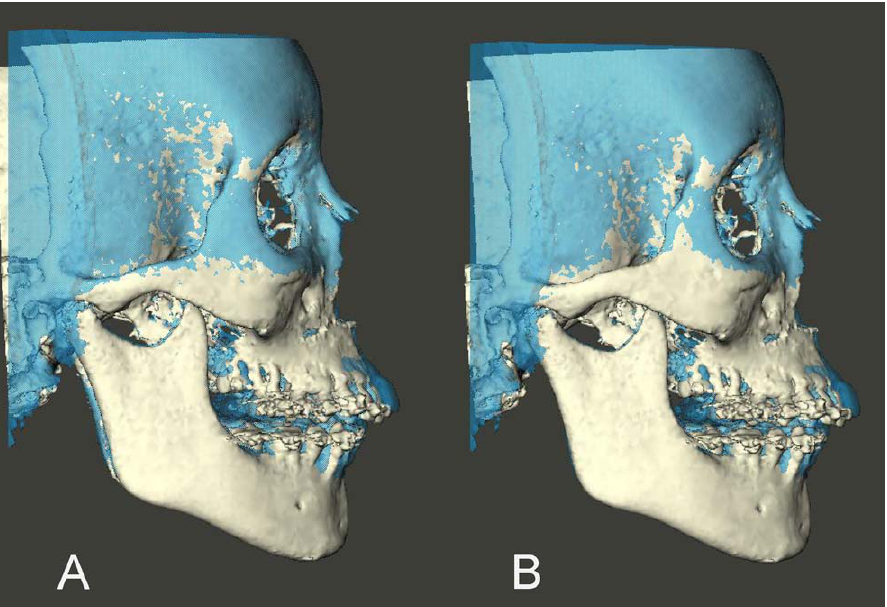
Figure 2. Transparency overlay of superimposed 3D CBCT models. Right side view. (A) models registered on the anterior cranial base. (B) same models registered on the left zygomatic